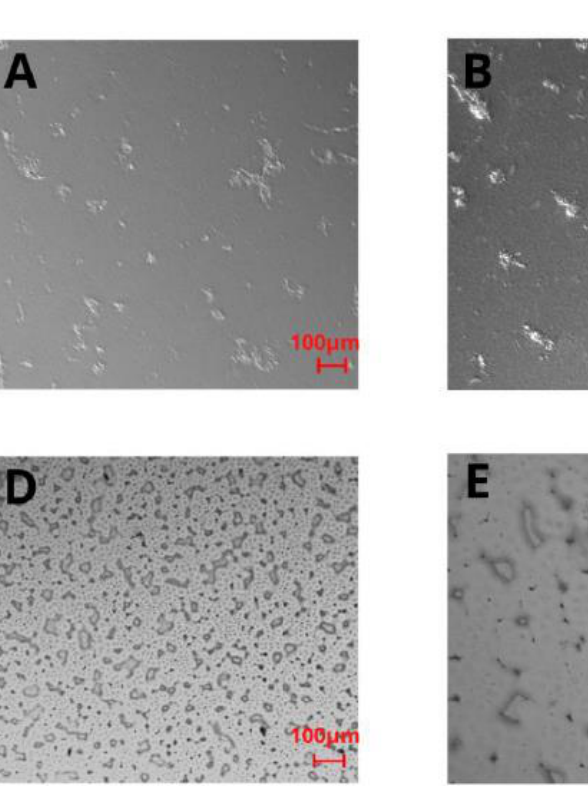
Figure 2. Polarized light images of PLA ( A – C ) and P(3HO) ( D – F ) films in 5 × magnification ( A , D ), 10 × magnification ( B , E ), and 40 × magnification ( C , F ).